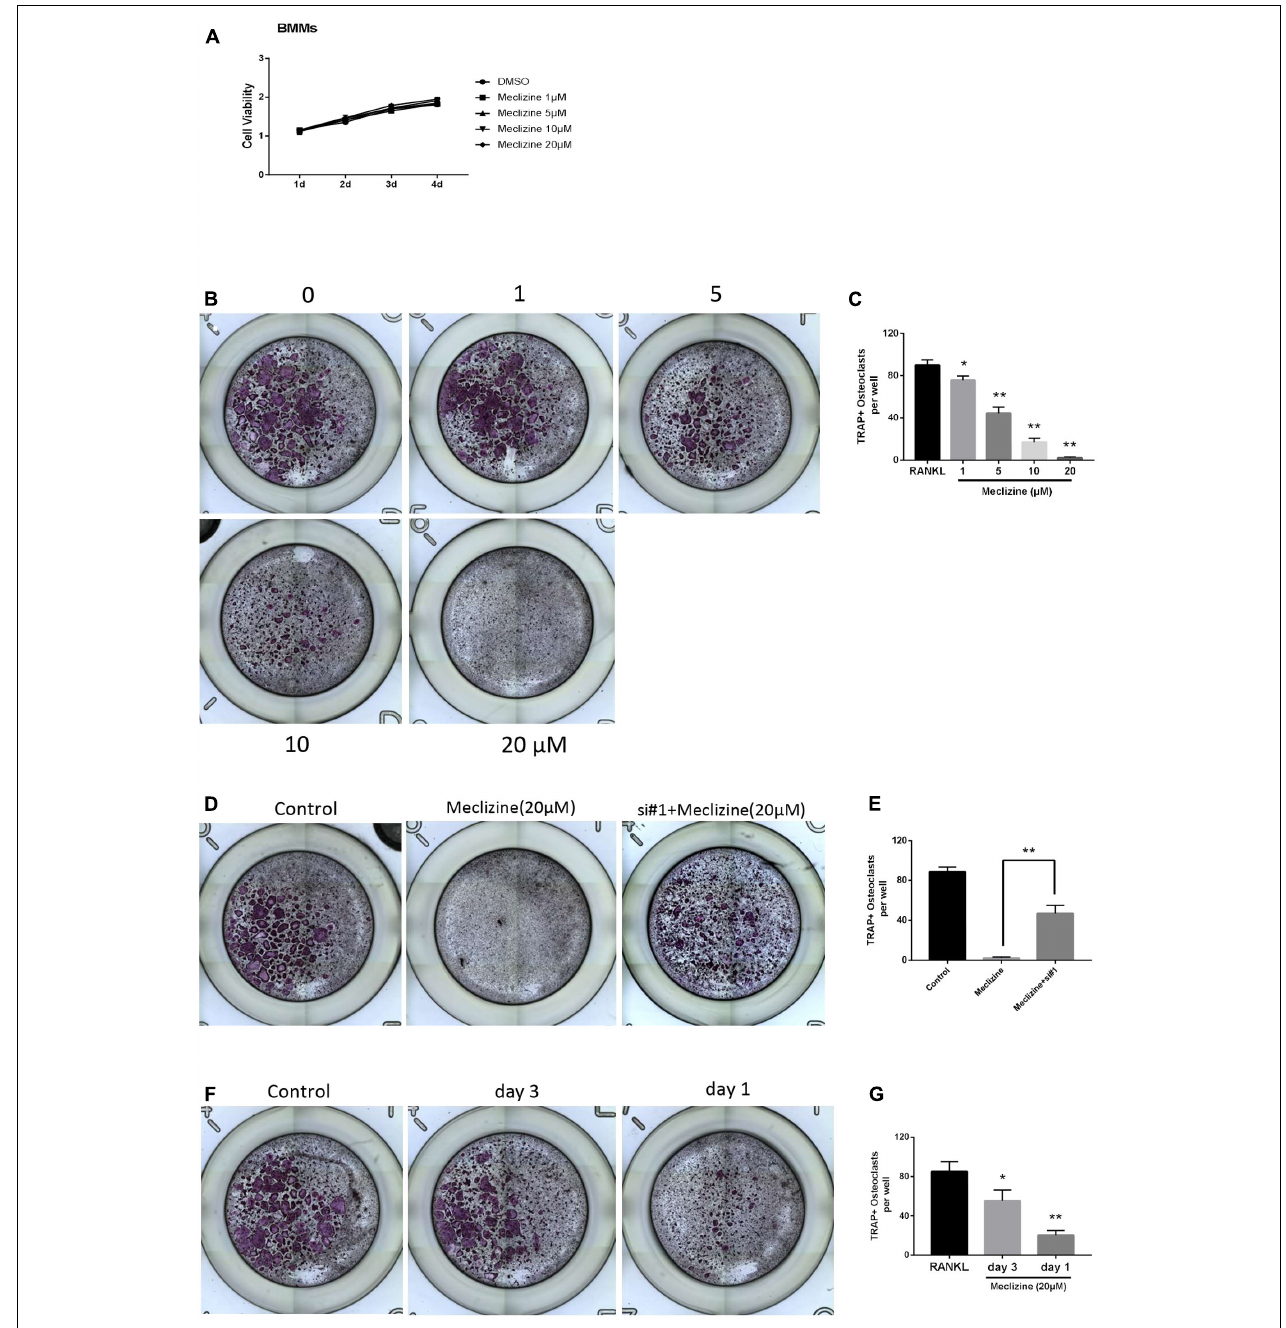
FIGURE 2 | Meclizine inhibits RANKL-induced osteoclast formation. (A) Meclizine has a tiny effect on proliferation of BMMs. BMMs (6 × 10 3 cells/well) were cultured with M-CSF (30 ng/mL) and various doses of meclizine (0, 1, 5, 10, and 20 µ M) for 4 days. Data are presented as mean ± SD of 3 independent experiments. (B,C) Meclizine inhibits osteoclastogenesis in a dose-dependent manner. BMMs (1.0 × 10 4 cells/well) were treated with different concentrations of meclizine every day in the presence of RANKL (100 ng/mL) and M-CSF (30 ng/mL) for 4 days. Then, the cells were stained for TRAP assay. TRAP-positive multinucleated osteoclasts ( ≥ 3 nuclei) were counted. Data are presented as means ± SD of three independent experiments. ∗ P < 0.05, ∗∗ P < 0.01 versus RANKL group. (D,E) BMMs (1.0 × 10 4 cells/well) were incubated with RANKL (100 ng/mL), M-CSF (30 ng/mL), meclizine (20 µ M) with or without PXR siRNA. Cells were used for TRAP staining after 4 days, and TRAP-positive multinucleated osteoclasts ( ≥ 3 nuclei) were counted. Data are presented as means ± SD of 3 independent experiments; ∗∗ P < 0.01. (F,G) BMMs (1.0 × 10 4 cells/well) were cultured in the presence of RANKL (100 ng/mL) and M-CSF (30 ng/mL) for 4 days and treated with meclizine (20 µ M) at the indicated times. Subsequently, TRAP staining was performed, and TRAP-positive osteoclasts ( ≥ 3 nuclei) were counted. Data are presented as means ± SD of 3 independent experiments; ∗ P < 0.05, ∗∗ P < 0.01 versus RANKL group.